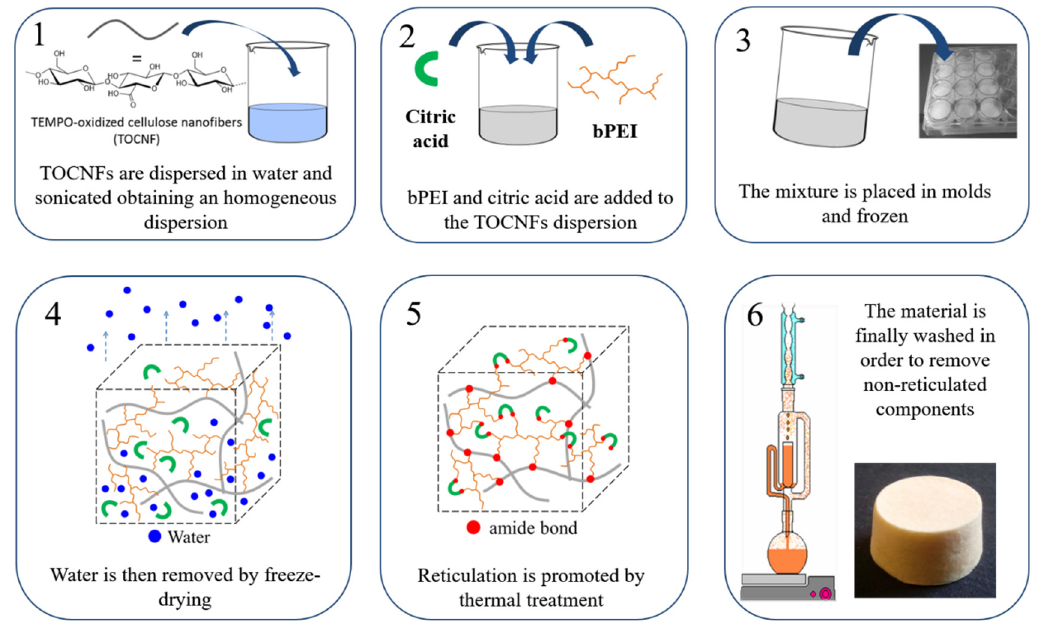
Figure 1. Synthetic procedure for the production of cellulose-based nanosponges CNS.